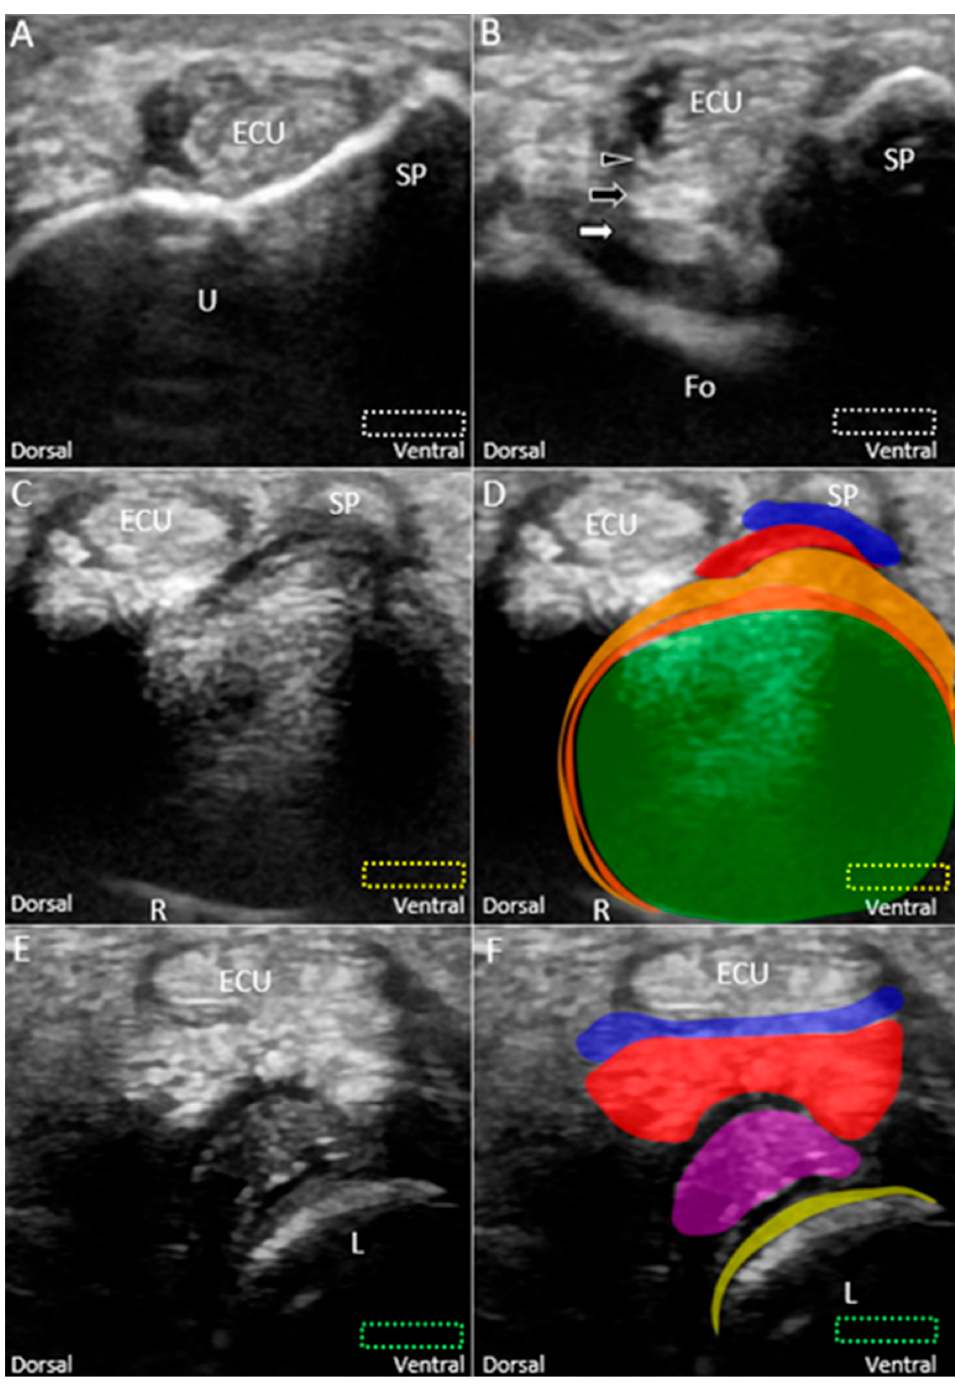
Figure 6. Imaging of the ulnar fovea using the short ‐ axis approach. ( A ) The transducer is placed above the ulnar styloid process at first. It is then moved distally and tilted to the cranial aspect. ( B ) US imaging of the ulnar fovea shows the deep (white arrow) and superficial limbs (black arrow) of the radioulnar ligament and the ulnar collateral ligament (black arrowhead) . ( C ) US and ( D ) superposed US images of the articular disc above the sigmoid notch of the radius. ( E ) US and ( F ) superposed US images of the lunotriquetral ligament and meniscus homologue. The different color dashed rectangles are in accordance with the transducer positions in Figure 3. US: ultrasound; U: ulna; R: radius; L: lunate; SP: styloid process; Fo: fovea; ECU, extensor carpi ulnaris. Articular disc (green shade) , radioulnar ligament (brown shade) , ulnar collateral ligament (blue shade) , lunate cartilage (yellow shade) , ulnotriquetral ligament ( purple shade) , and meniscus homologue (red shade)